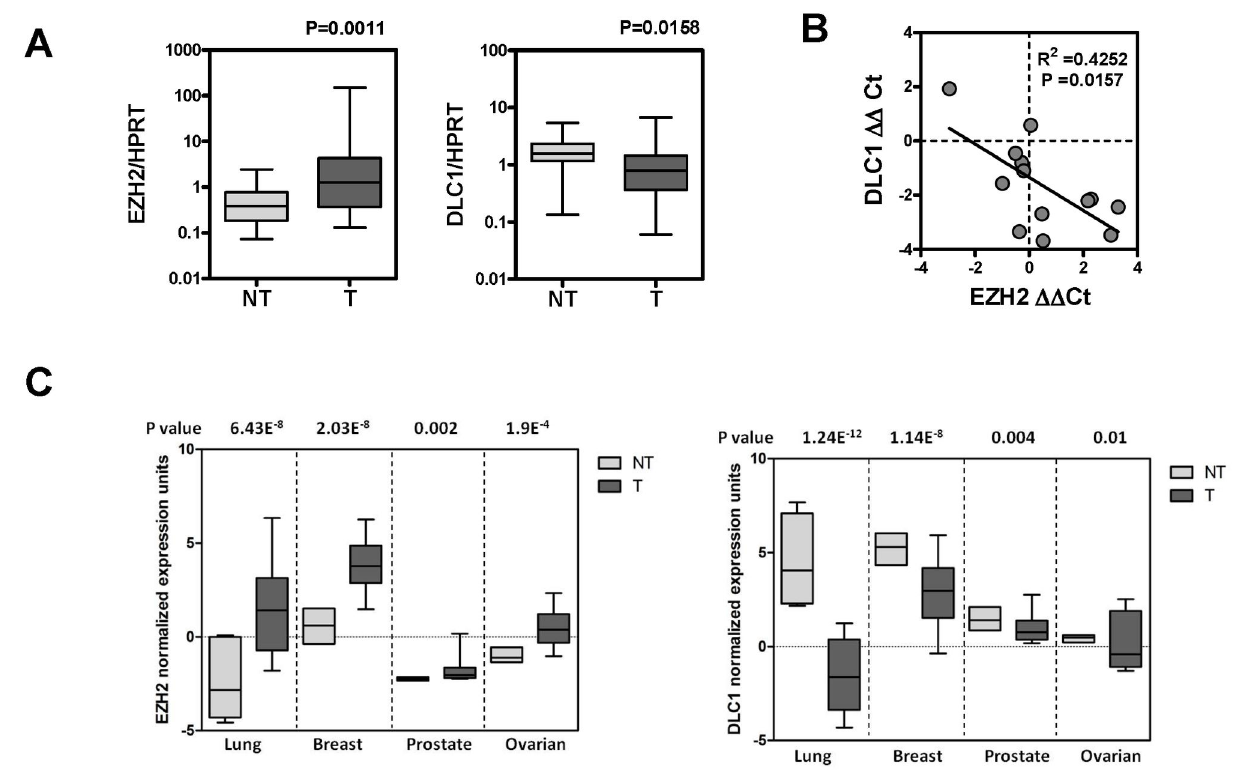
Figure 3. Inverse correlation between EZH2 and DLC1 expressions in human cancers. ( A ) Twenty five-paired HCC samples were examined for EZH2 and DLC1 mRNA expression by qPCR. EZH2 was significantly up- regulated in HCC tumorous (T) tissues than non-tumorous (NT) tissues (left panel). In the same sample cohort, DLC1 was significantly down-regulated in HCC as compared to NT tissues (right panel). P values from Wilcoxon matched pair test. ( B ) An inverse correlation was observed between EZH2 and DLC1 expression in a subset of HCC samples without DLC1 promoter methylation. Expression level of EZH2 and DLC1 in paired-HCC samples was represented by ΔΔCt (T -NT (HPRT Ct –Gene of interest Ct) (HPRT Ct – ). Linear regression analysis was performed using GraphPad Prism5 (La Jolla, CA, USA). ( C ) EZH2 upregulation (left Gene of interest Ct) panel) and concomitant DLC1 downregulation (right panel) was consistently observed in the tumorous tissues of different cancers, including lung [32], breast [33], prostate [34] and ovarian [35] cancers. Expression data and P values of DLC1 and EZH2 in multiple cancer types was obtained from Oncomine microarray database. Floating bars were shown to illustrate the minimum, median and maximum normalized expression units in non-tumorous (NT) and tumorous (T)